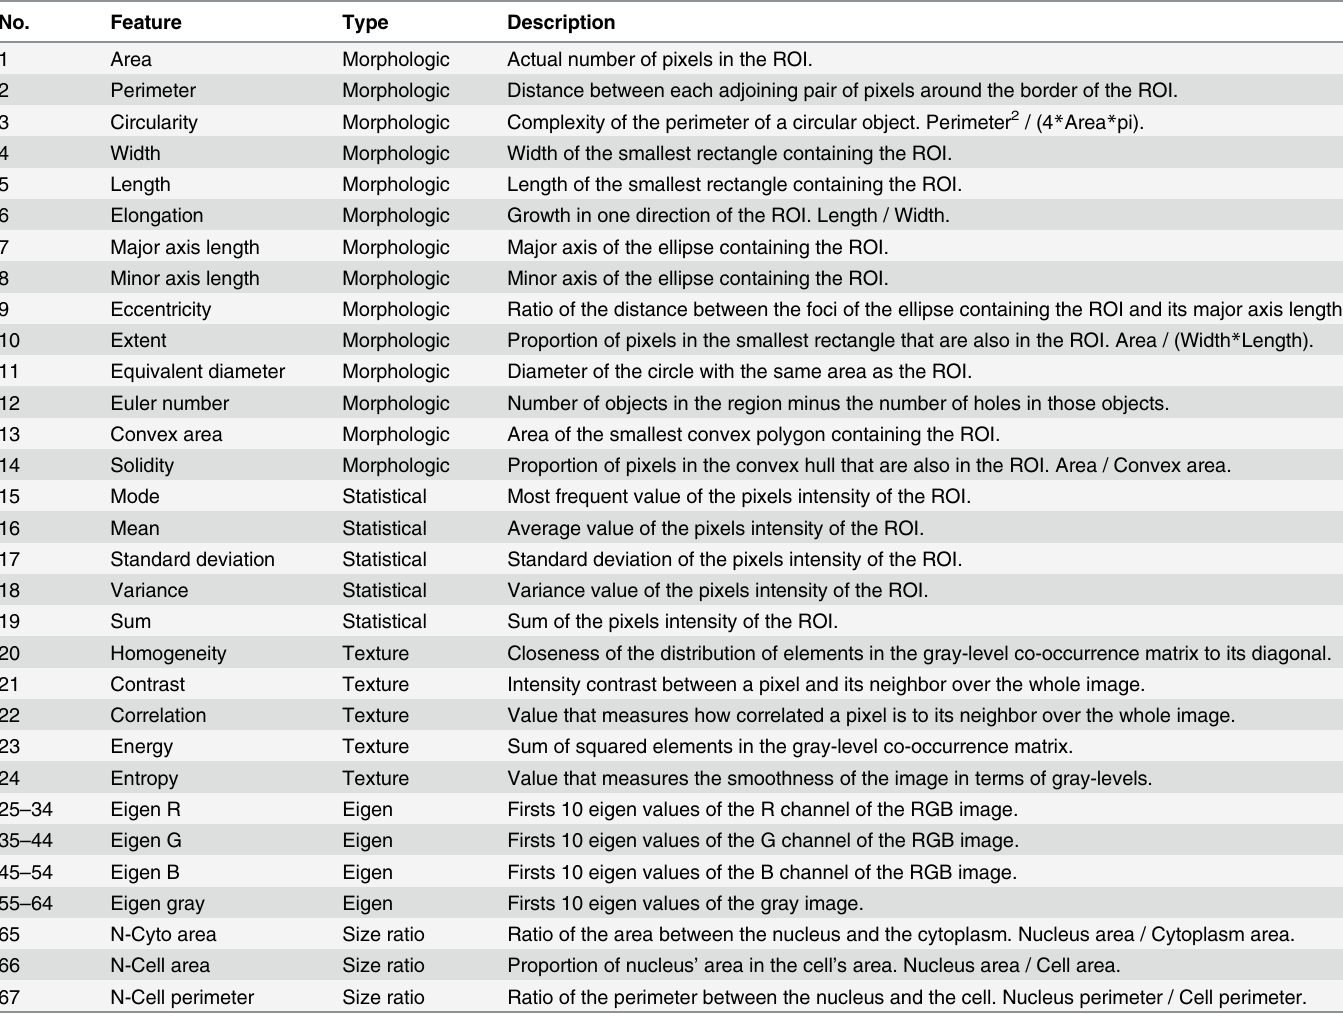
Table 1. Representative features for the cell